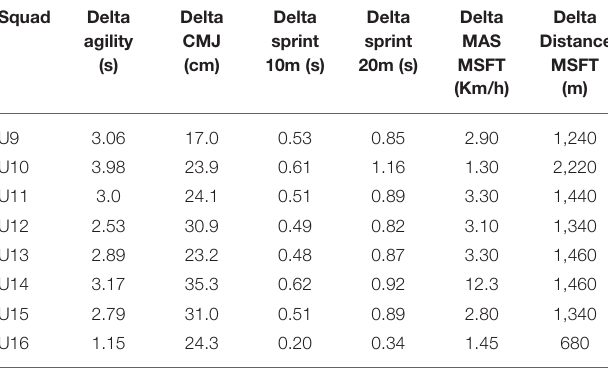
TABLE 3 | Delta values indicate variation for physical parameters as agility, jump performance (CMJ), sprint capacity (10 m/20m) and endurance capacity (MSFT) before allocation.